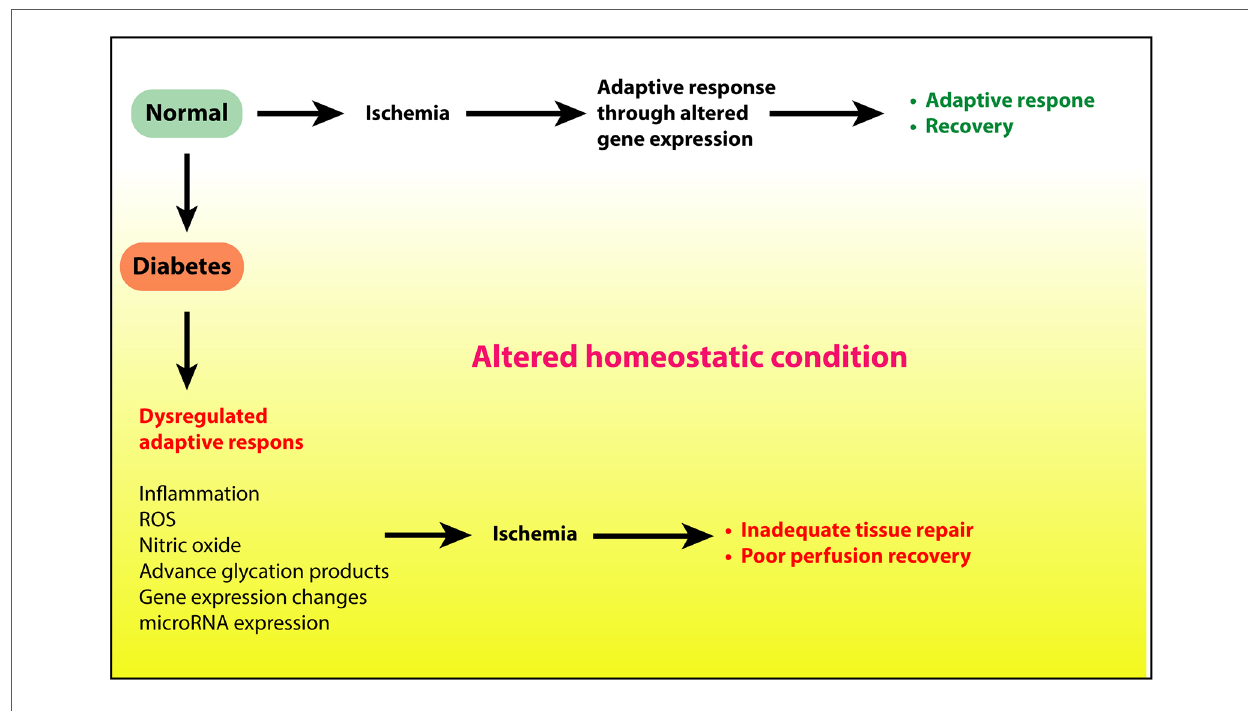
FIGURE 1 Ischemic injury to limbs under normal conditions elicits adequate adaptive response to restore tissue health and perfusion. However, under diabetic conditions, hyperglycemia, insulin resistance, or a combination of these, alters the tissue homeostatsis through increased in fl ammation, reactive oxygen species, and other proin fl ammatory processes. This altered state in turn delays or prevents the adaptive response to repair the